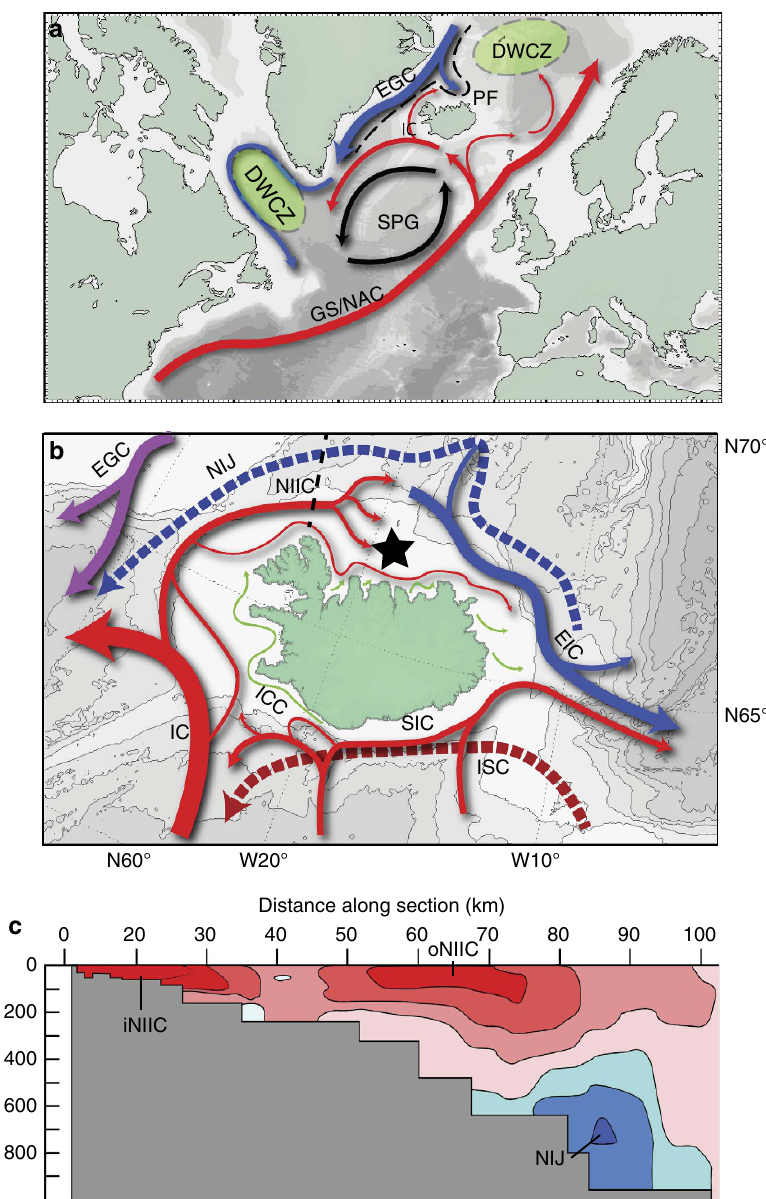
Figure 1 | Maps of the modern surface currents of the North Atlantic and Icelandic shelf. ( a ) North Atlantic circulation and ( b ) North Icelandic shelf circulation pattern. Arrows shown in blue correspond to cool and relatively fresh Arctic-sourced waters; arrows shown in red are warm and saline Atlantic-sourced waters; dashed lines correspond to deep currents whilst the solid arrows denote surface currents. The dashed black line in a refers to the approximate position of the North Atlantic Polar Front. The dashed black line in b refers to the depth transect shown in c . The star denotes the location of the shell sampling site (80m water depth 66 (cid:2) 31.59 0 N, 18 (cid:2) 11.74 0 W). ( c ) Depth transect across the North Icelandic shelf indicating the direction of flow of each of three dominant water currents at this locality. Red colours indicate an easterly flow whilst blue indicates a westerly flow. DWCZ, deep water convection zones; EGC, East Greenland Current; EIC, East Icelandic Current; GS/NAC, Gulf Stream/North Atlantic Current; IC, Irminger Current; iNIIC, inner NIIC; ISC, Icelandic slope current; NIIC, North Icelandic Irminger Current; NIJ, North Icelandic Jet; oNIIC, outer NIIC; PF, polar front; SIC, South Icelandic Current. ( b , c ) Adapted from ref. 27 and the base map from ref.